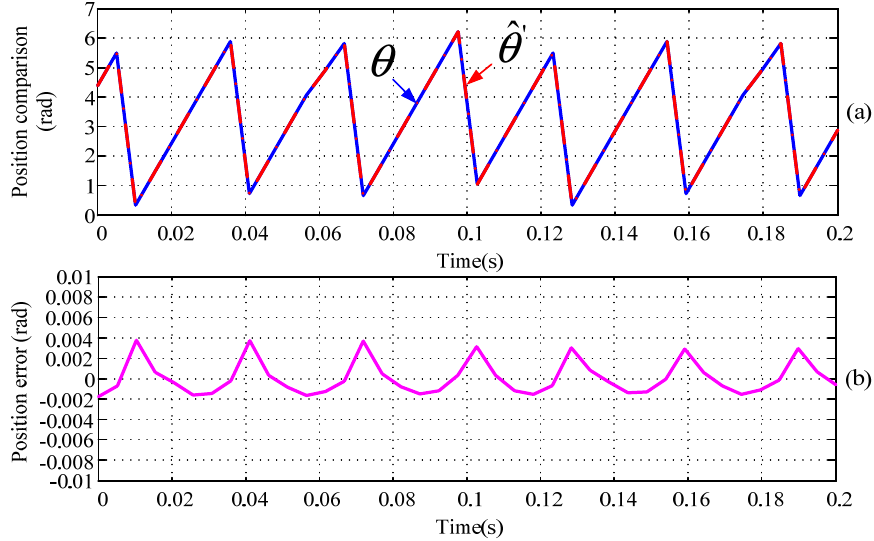
θ θ ) and rotor angle ) and rotor angle